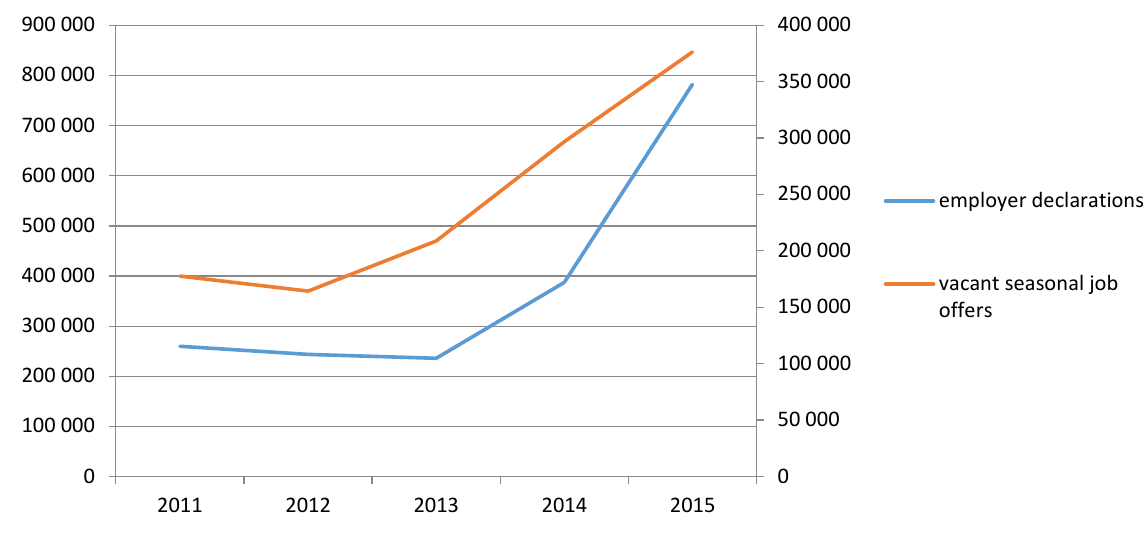
Figure 7. Declarations submitted (left axis) and vacant seasonal job offers (right axis) in Poland, 2011–2015